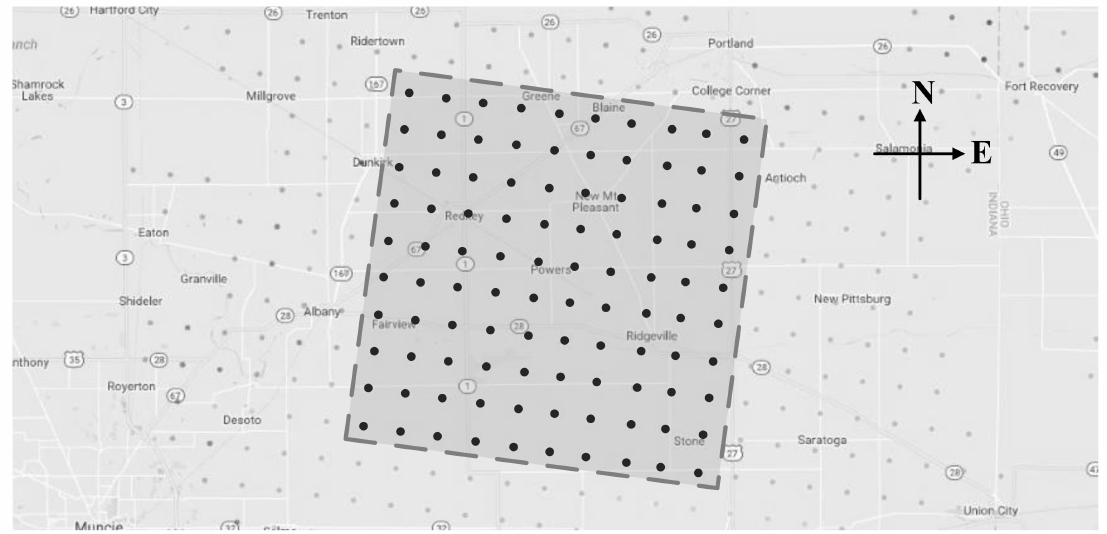
Figure 6. The 10 × 10 wind turbine array in Indiana. Each wind turbine is marked as a black